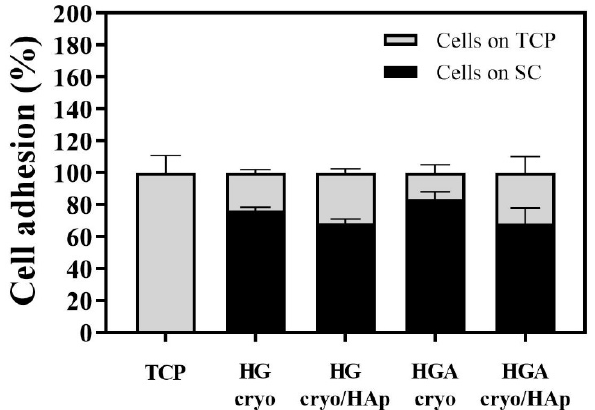
Figure 4. hMSC adhesion on day 1 after seeding. A majority of the seeded cells were able to adhere to the scaffolds with or without HAp (HG cryo , HG cryo /HAp, HGA cryo , HGA cryo /HAp) 1 day after seed-